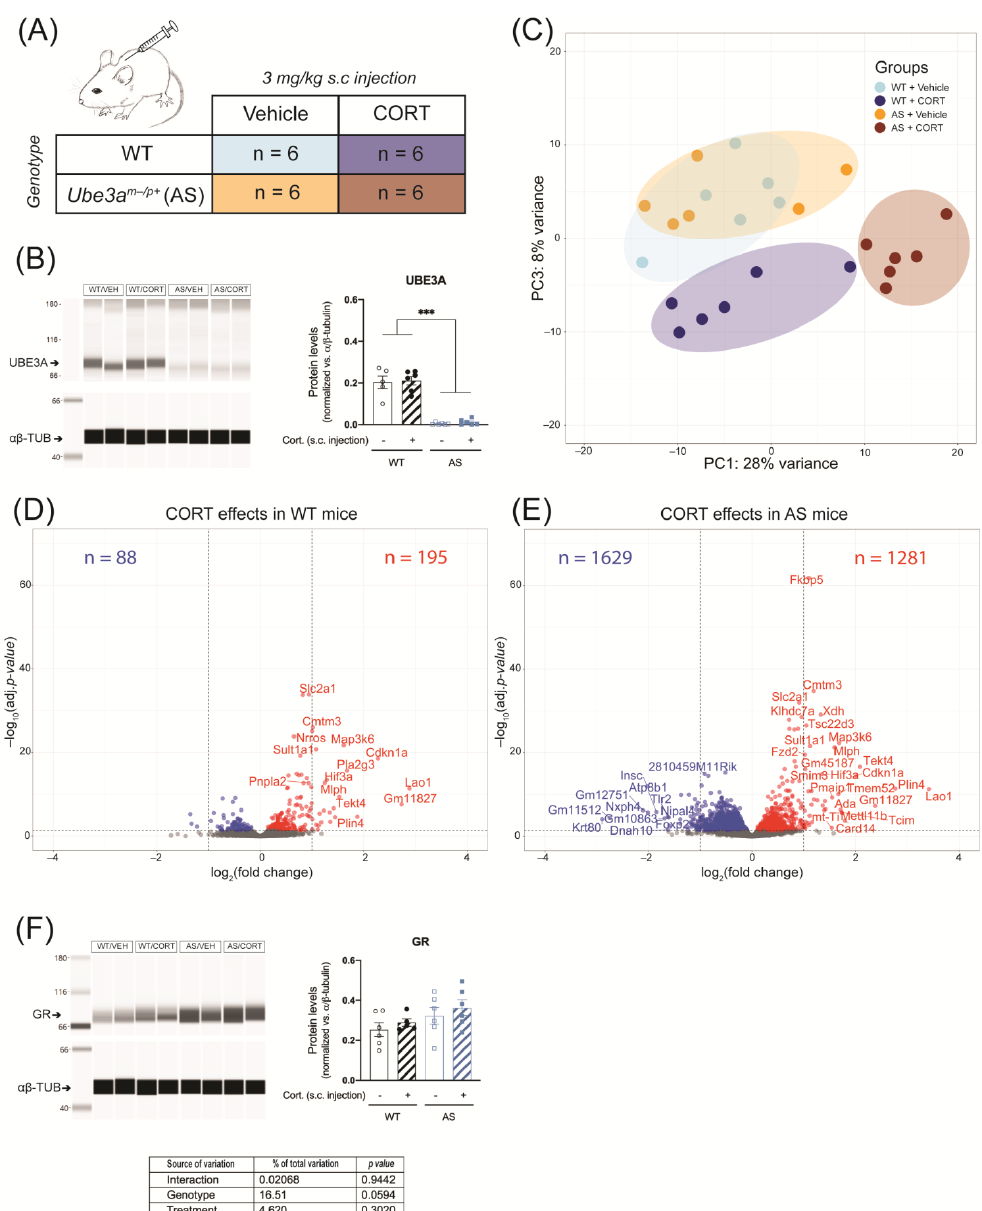
Figure 3. Acute corticosterone exposure strongly alters hippocampal GR signaling in UBE3A-deficient AS mice. ( A ) WT and AS mice were subcutaneously (s.c.) injected with vehicle or 3 mg/kg corticosterone ( n = 6/group). ( B ) UBE3A protein expression in the frontal cortex of WT and AS mice after acute treatment with vehicle or corticosterone, normalized against αβ -tubulin levels ( αβ -TUB).